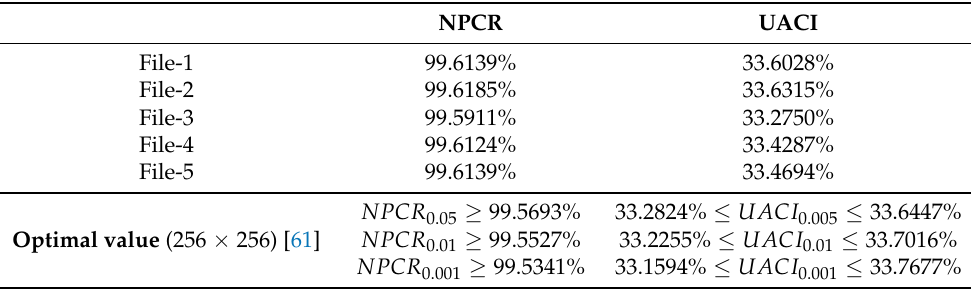
Figure 6. Original and encrypted statistical histograms. Table 5. NPCR and UACI randomness